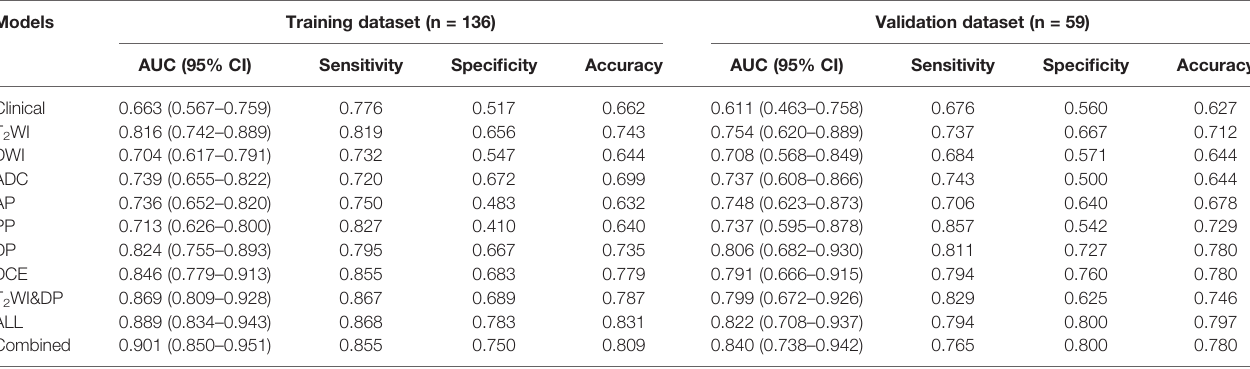
TABLE 3 | Predictive performance of different